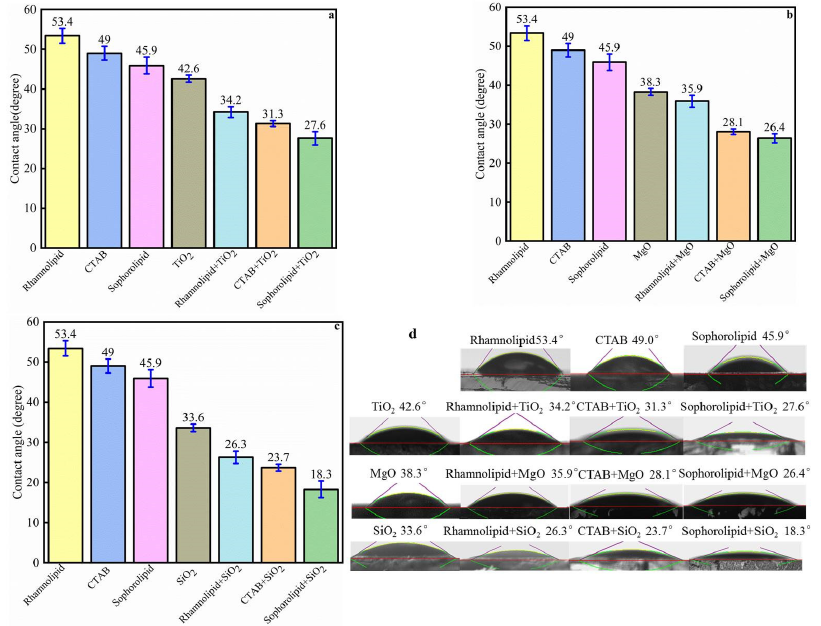
Figure 21. Synergistic effect of nanofluids and surfactants on oil-wet calcite wettability: ( a ) TiO 2 and surfactants; ( b ) MgO and surfactants; ( c ) SiO 2 and surfactants; ( d ) measurement